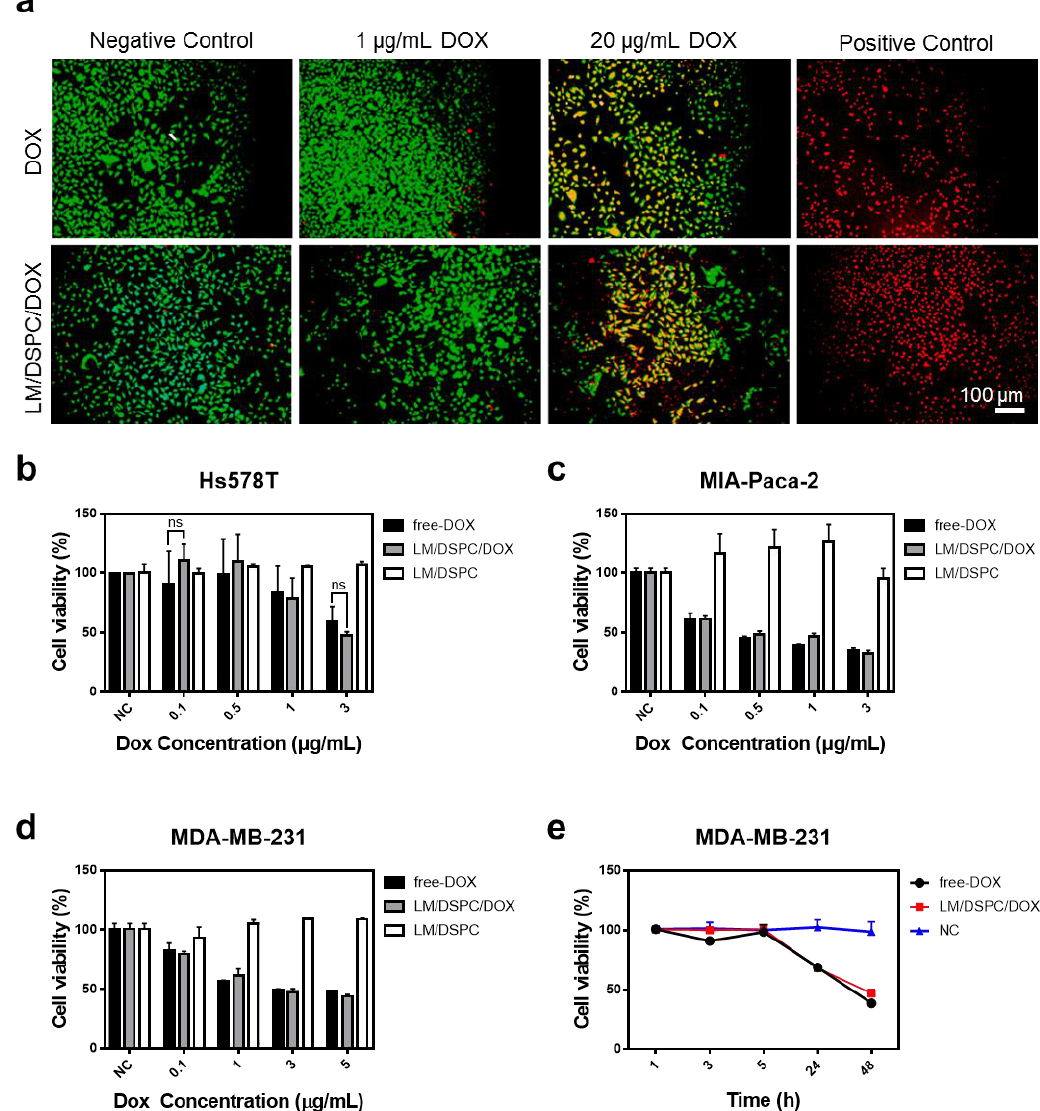
Figure 4. The e ff ect of LM / DSPC / DOX particles on cell viability. ( a ) A live / dead cell viability assay showing live cells stained with calcein-AM (green) and dead cells stained with EthD-1 (red). ( b ) Viability of pancreatic cancer cells treated with LM / DSPC / DOX particles loaded with increasing concentrations of doxorubicin. ( c , d ) Viability of breast cancer cells treated with LM / DSPC / DOX particles loaded with increasing concentrations of doxorubicin. ( e ) The cytotoxicity of the nanoparticles on MDA-MB-231 cells depends on time (NC = negative